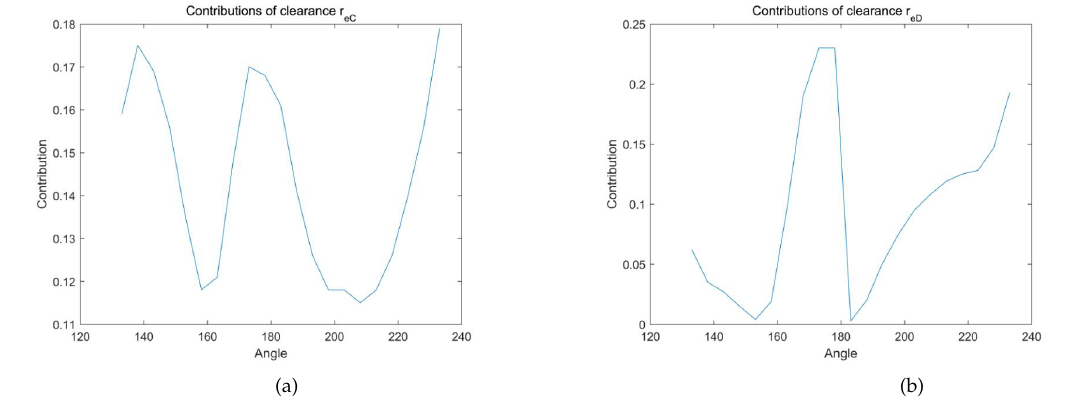
Figure 7. ( a ) The contributions of r eC ; ( b ) The contributions of r eD .